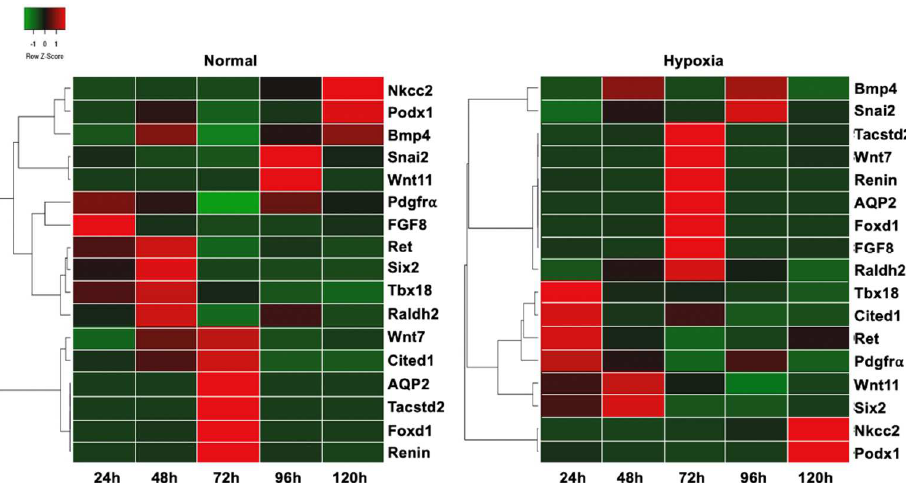
Figure 6. Gene expression of progenitor and differentiation markers of embryonic kidneys. Heatmap showing hierarchically clustered gene expression data of progenitor and differentiation markers of embryonic kidneys in hypoxic culture, compared to normal condition. Gene expression is presented for 24 h, 48, 72 h, 96 h, and 120 h. Genes that show higher expression in hypoxic condition than in normal control are in red, green is associated with a reduction in mRNA level.